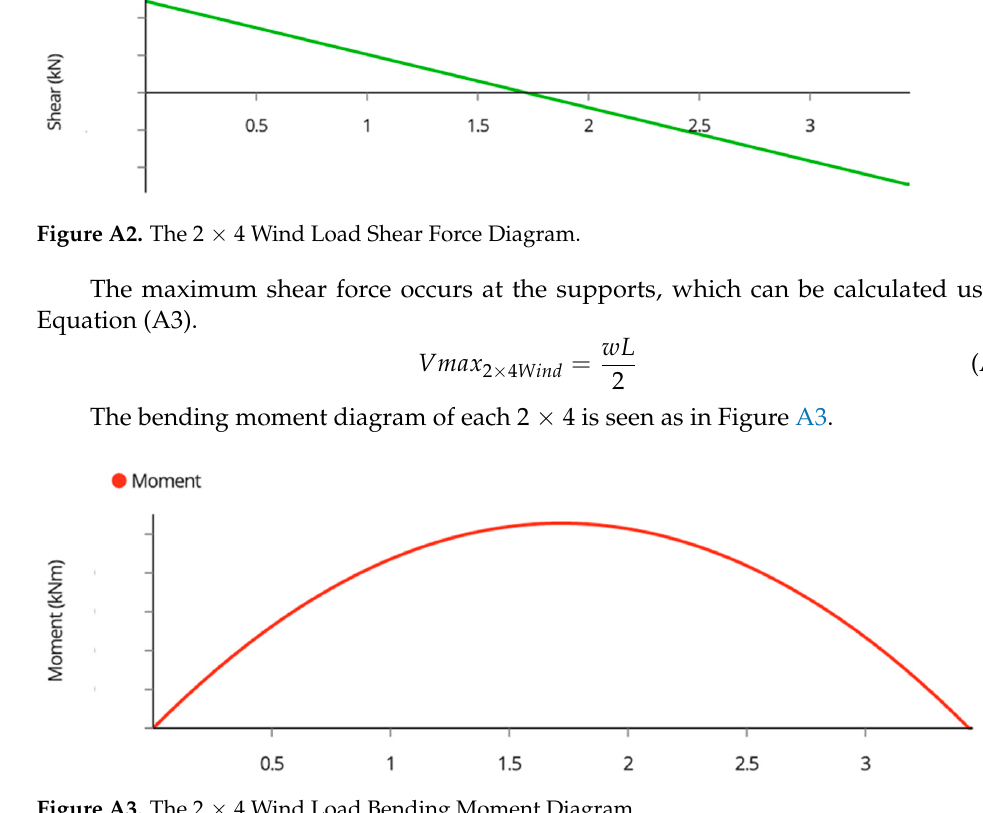
Figure A3. The 2 × 4 Wind Load Bending Moment Diagram. The maximum bending moment occurs at midspan. The maximum bending moment can be calculated by Equation (A5). The deflection diagram throughout each 2 × 4 is seen as in Figure A4.